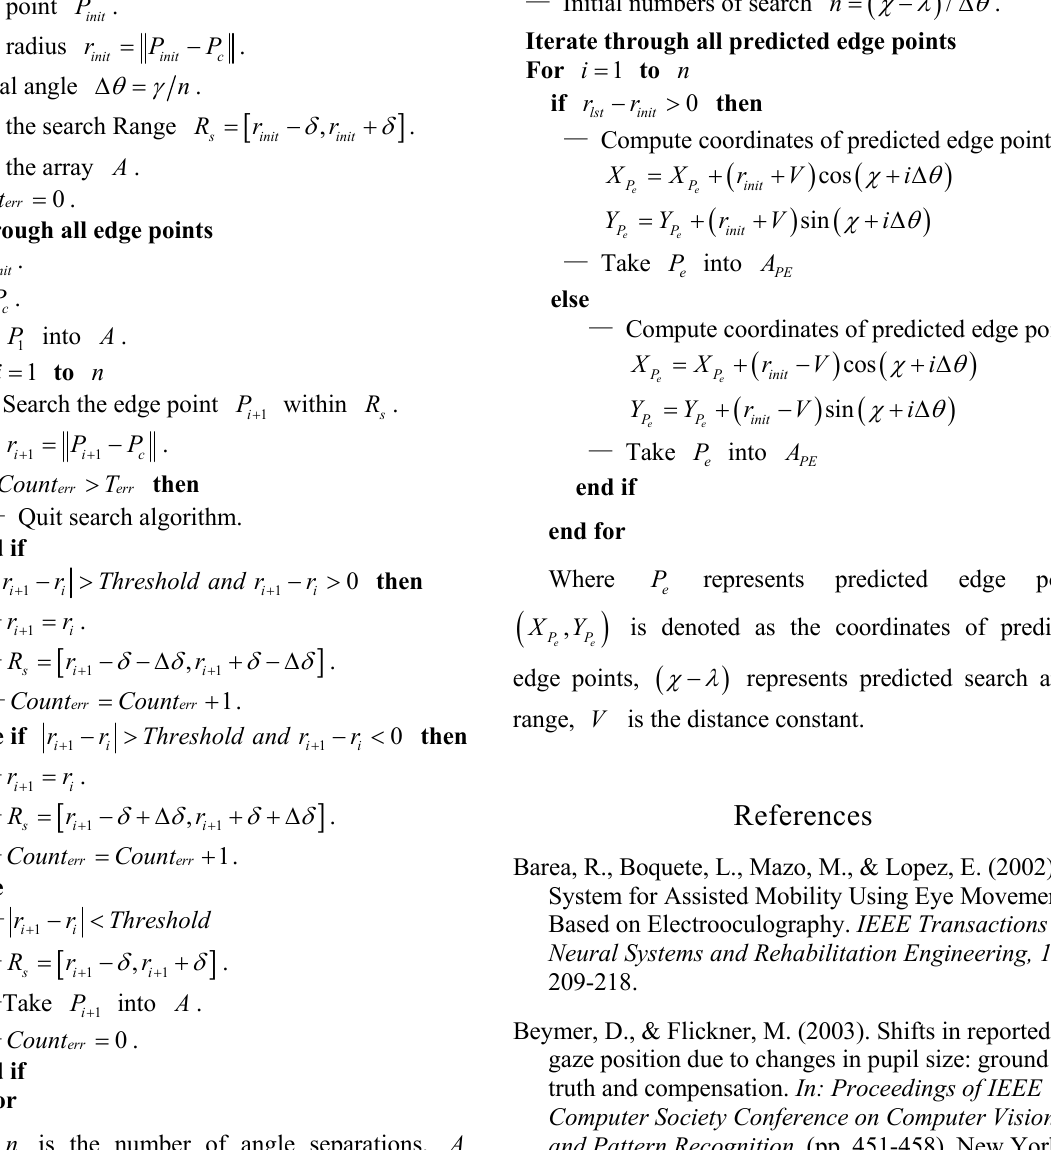
Algorithm1 Pseudocode of iris edge points detection as shown in the Pseudocode below Initialize